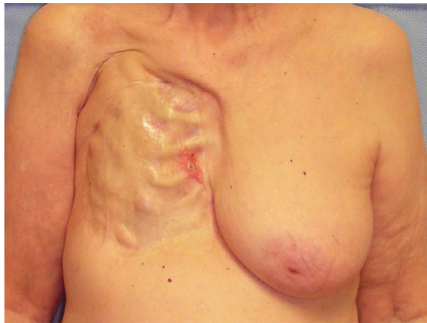
Figure 2: The same patient after chest wall lesion excision and local tissue rearrangement using the skin from her contralateral